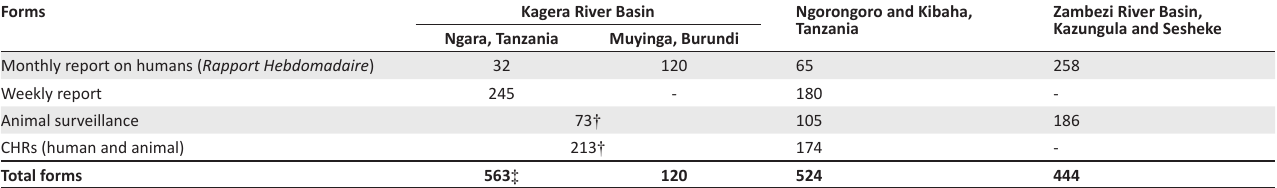
FIGURE 8: Short messaging service codes submitted by community reporters recruited by Talib Suleiman, a PhD candidate at Sokoine University of Agriculture researching mastitis in Zanzibar, Tanzania, mapped into question map and answers, respectively, in the Swahili language. TABLE 1: The total number of forms submitted for the Kagera River Basin between September 2012 and May 2013, for the Ngorongoro and Kibaha districts between January 2011 and May 2013 and for Zambezi River Basin between July 2012 and May 2013. Forms Kagera River